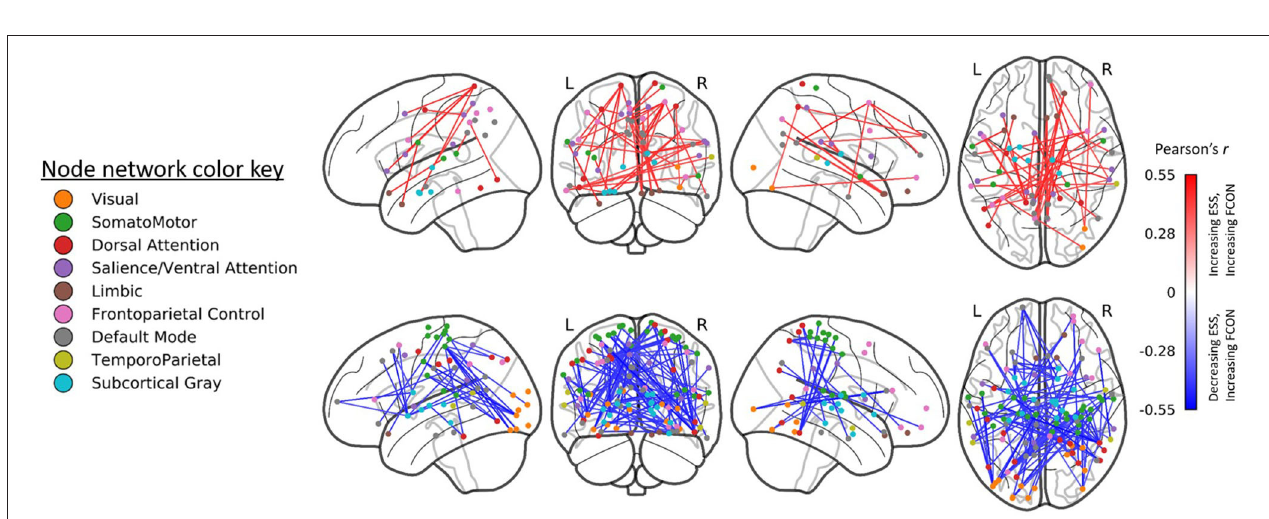
FIGURE 3 | Regions of interest (ROIs) exhibiting moderate-to-large correlations (| r | > 0.4) between Epworth Sleepiness Scale scores and gray matter volume (GMV) at baseline (left) and at post-treatment (right). Treatment-related decreases in daytime sleepiness were associated with moderate-to-large increases in GMV in 74 ROIs. All ROIs were FDR corrected at p < 0.05.